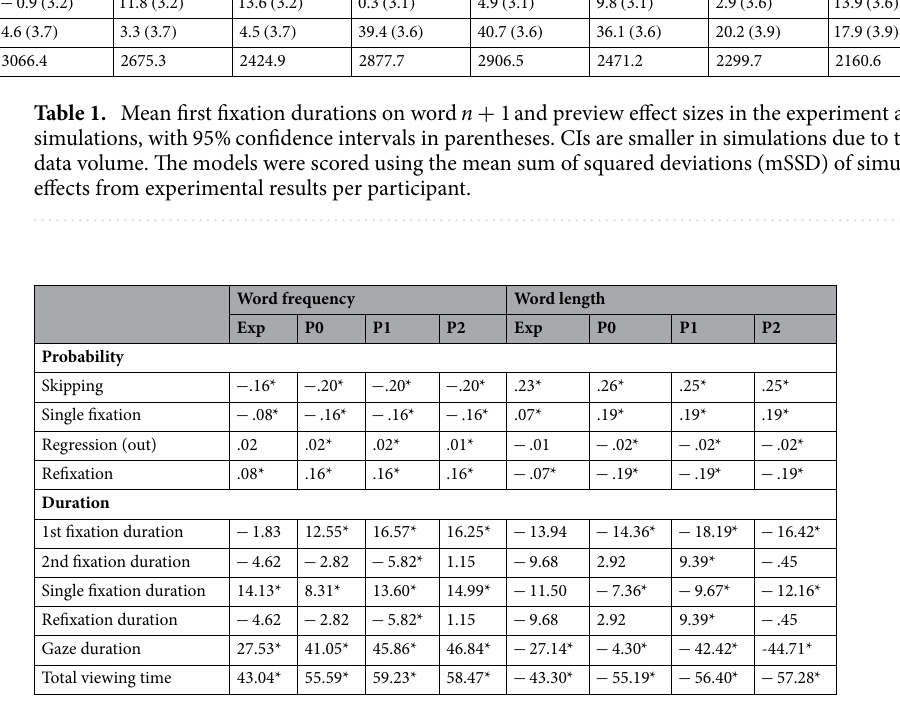
Table 2. Effects of word frequency (LF–HF) and word length (long–short) for various measures of fixation durations and fixation probabilities for experimental and model simulations data of the control condition (MF). These summary statistics refer to the control condition without boundary manipulation, i.e., different model variants with saccade cancelation do not apply here. Frequency and length classes (from 2nd word to word n-1 in the sentence including target word) were determined via median split. Asterisks indicate differences, where p < .05 (Welch’s t